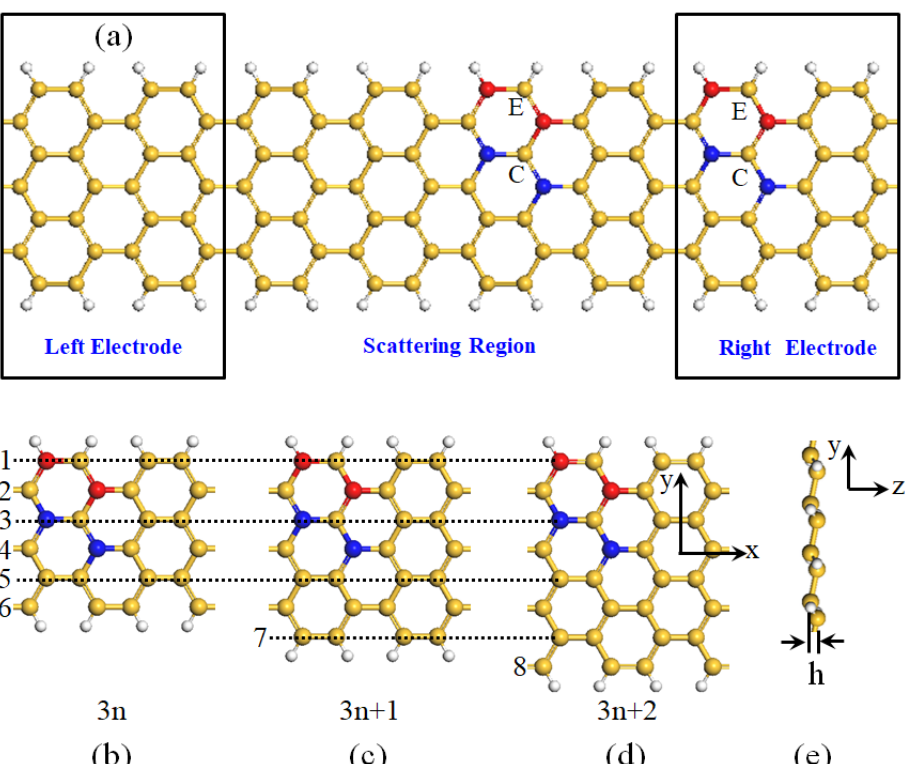
Figure 1. ( a ) The schematic illustration of two-probe system based on ASiNR device. ( b – d ) Model of AA − P 2 ASiNRs with different widths: N = 3n (6); 3n + 1 (7); and 3n + 2 (8). The colored atoms represent substitutional doping of AA − P 2 and the labels with C and E denote the dopants at the center (blue atoms) and the edge (red atoms), respectively. ( e ) Side view of ASiNRs. The white in each diagram represents hydrogen atoms.